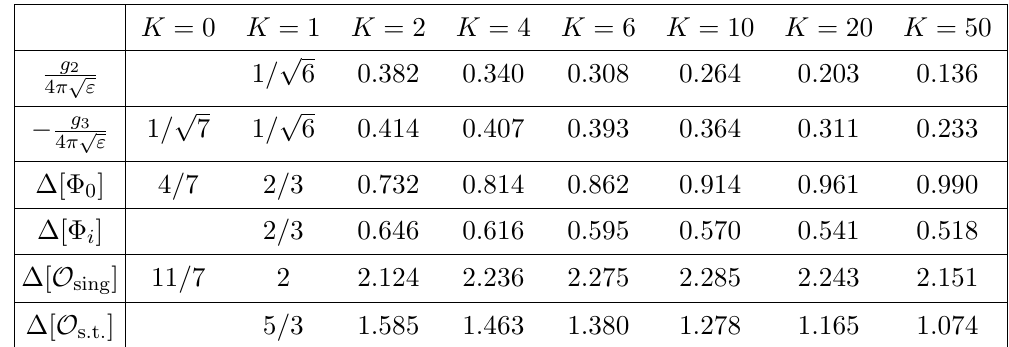
(cid:8) 0 P K (cid:8) 2 + g 3 (cid:8) 3 at one-loop: coupling constants 0 i i =1 2 6